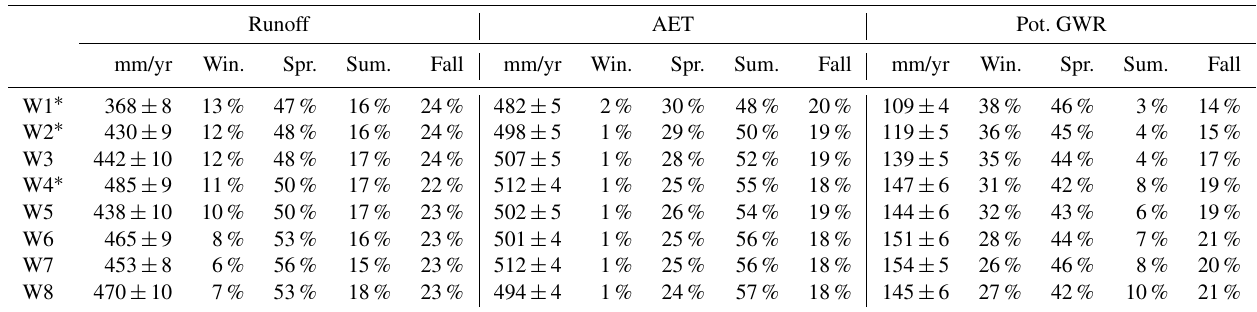
Table 4. Simulated runoff, actual evapotranspiration (AET), and potential groundwater recharge (GWR) and uncertainty for the study area between 1961 and 2017 for annual values, winter, spring, summer, and fall and for the eight watersheds (W1 to W8). Runoff AET Pot. GWR mm/yr Win. Sum.